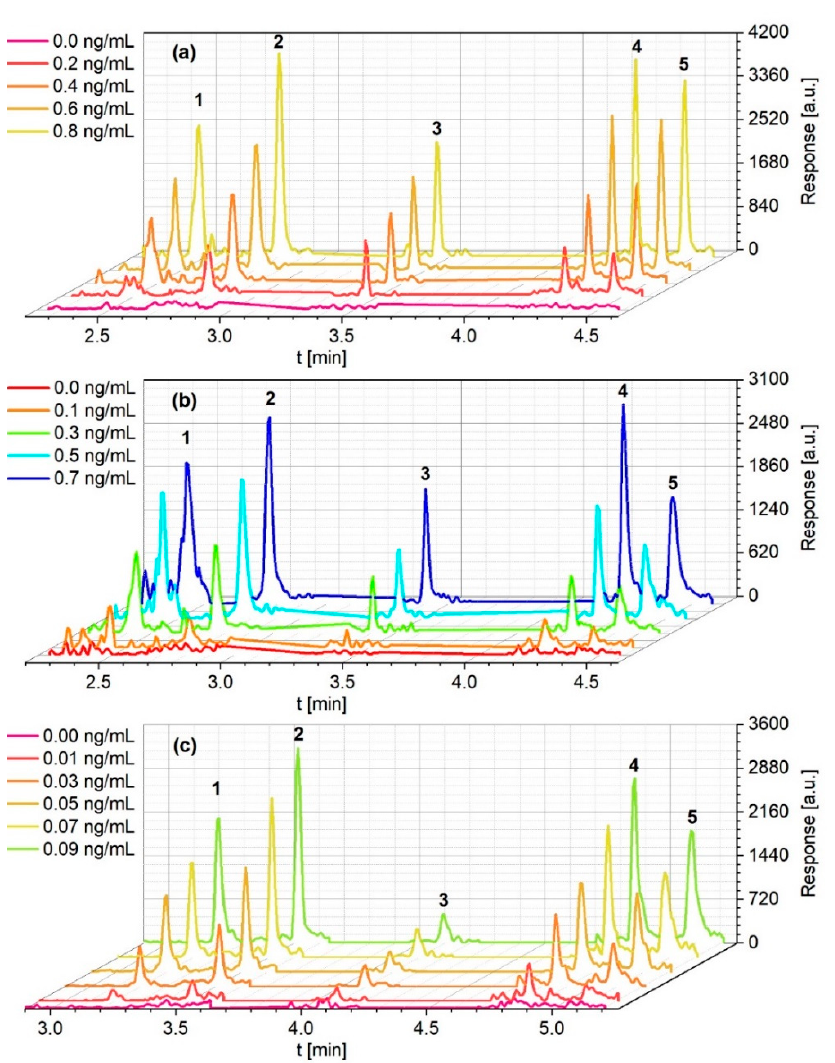
Figure 1. Chromatograms of the calibration standards used to determine the limits of detection (LODs) of the ( a ) splitless quartz wool ( b ) splitless CarboFrit and ( c ) programmable temperature vaporization—large volume injection methods. Peaks are 1: 1,3-dinitrobenzene (1,3-DNB); 2: 2,4-dinitrotoluene (2,4-DNT); 3: TNT; 4: 4-amino-2,6-dinitrotoluene (4-ADNT); 5: 2-amino-2,4-dinitrotoluene (2-ADNT).